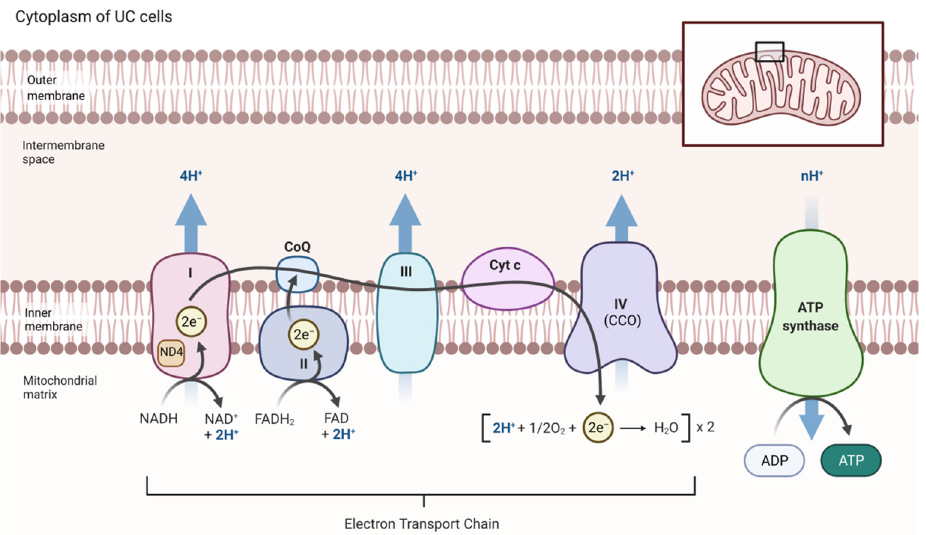
Figure 2. Schematic diagram of ETC in UC. ETC is located on the inner mitochondrial membrane and composed of five protein complexes. Mutations in the ND4 subunit of Complex I are found in UC. Complex IV is associated with progression and tumorigenesis UC. Abbreviations: CCO, cytochrome c oxidase; ND4, NADH dehydrogenase subunit 4. The figure was created with BioRender.com.